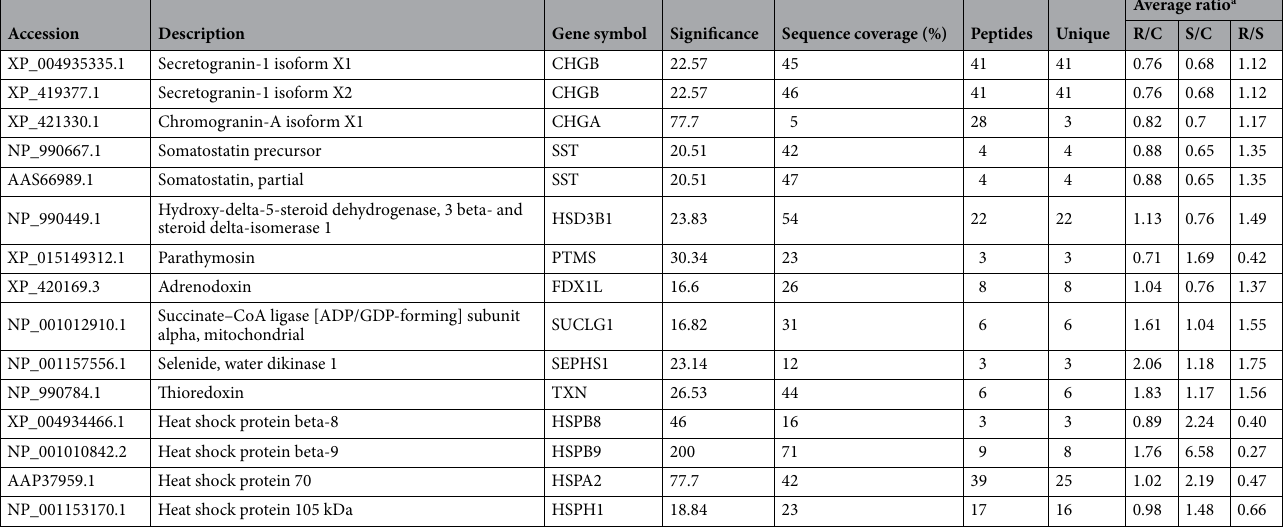
Table 1. Prominent differentially expressed proteins in the adrenal gland of male L2 strain Taiwan country chickens (TCCs) after acute heat stress. C control group, R resistant group, S susceptible group. a Only proteins with a 1.3-fold change for high (> 1.3) or low (< 0.77) relative level, as quantified through iTRAQ, were considered differentially regulated.